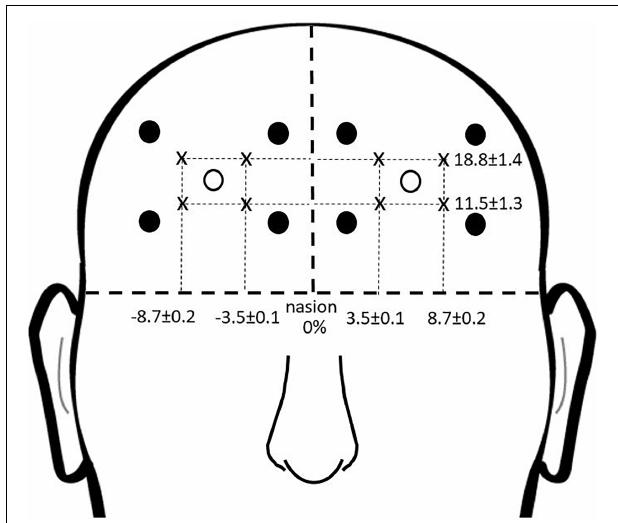
FIGURE 3 | fNIRS recording sites. Group mean fNIRS recording sites expressed as a percentage of head circumference (lateral direction) and nasion to inion distance (vertical direction). Light emitters are shown as closed circles and light detectors as open circles. The recording site is estimated as halfway between each emitter-detector pair, and shown with an